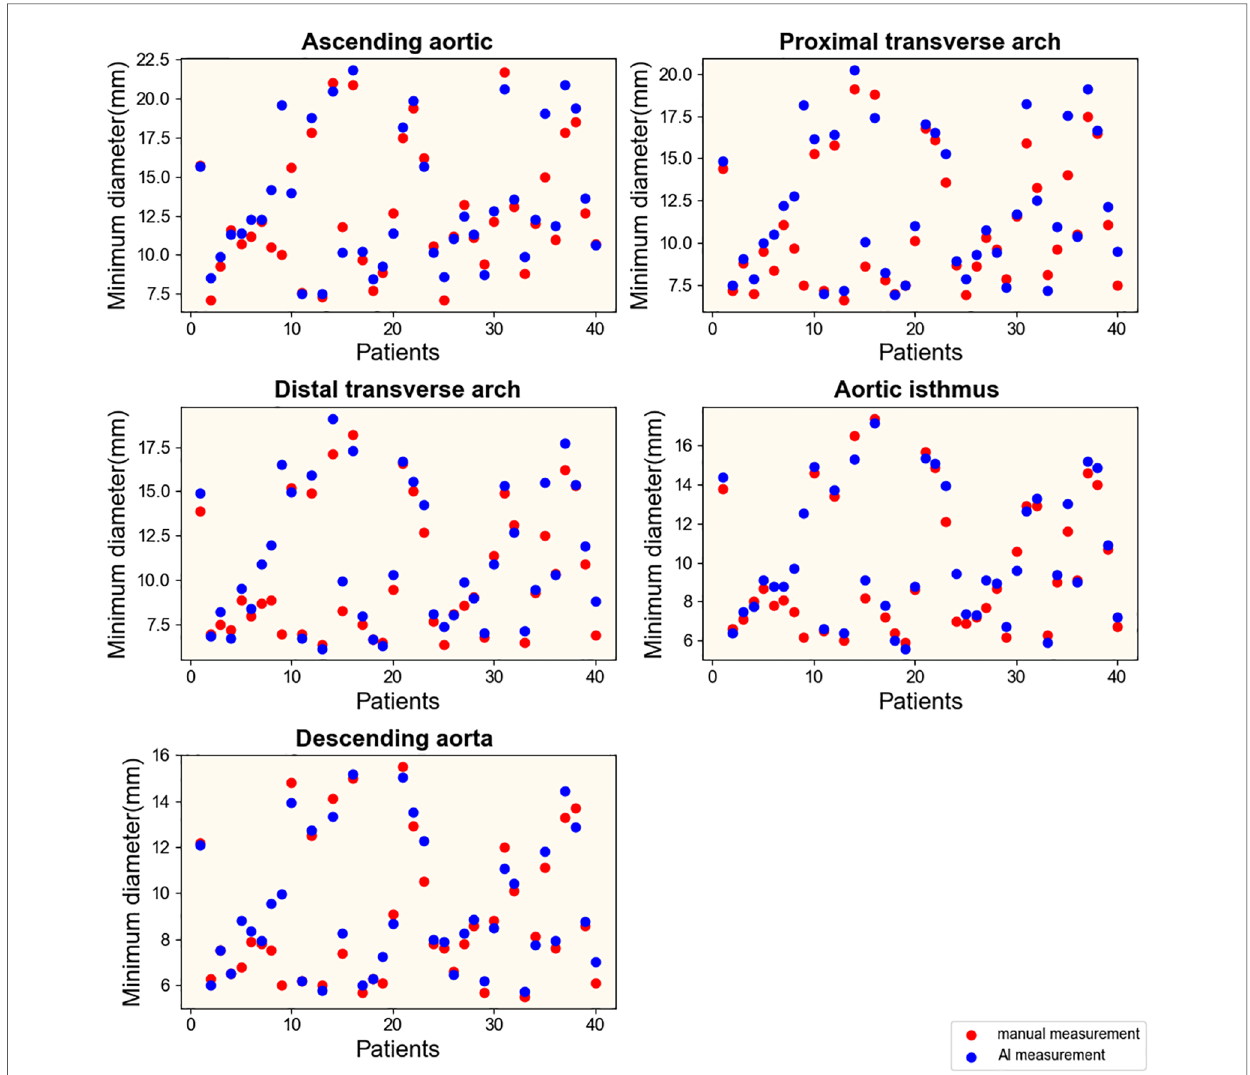
FIGURE 7 Results of measurements in patients without CoA. Manual and intelligent measurements were used to measure the minimum aortic diameter of 40 patients without CoA.